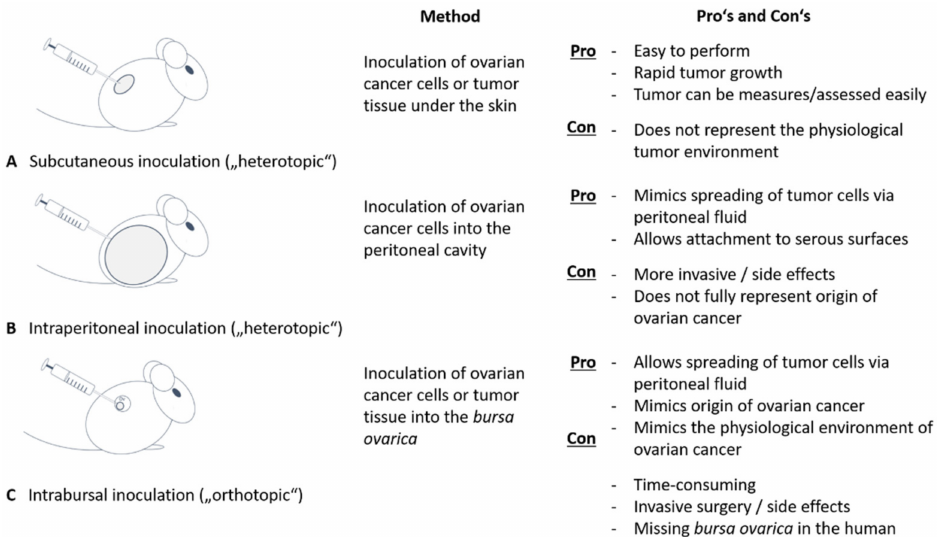
Figure 3. Mouse models in ovarian cancer research. Using mouse models have proved to be an important tool in ovarian cancer research. We differentiate between heterotopic mouse models, where ovarian cancer cells or cancer tissue is inoculated subcutaneously ( A ) or into the peritoneal cavity ( B ). Whereas a subcutaneous application is easy to perform and safe for the animal, it does not mimic the physiological tumor environment. In contrast, intraperitoneal application is able to imitate the spreading of tumor cells via peritoneal fluid and attachment to serous surfaces. As an orthotopic mouse model, intrabursal application is performed ( C ). The latter also imitates site of origin of ovarian cancer and mimics spreading and attaching of cancer cells, but is hampered by the fact that an ovarian pouch is missing in the